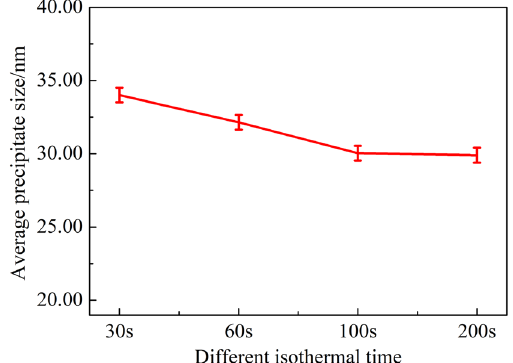
Figure 8: Statistics of average particle size of precipitates under the conditions of di ff erent isothermal